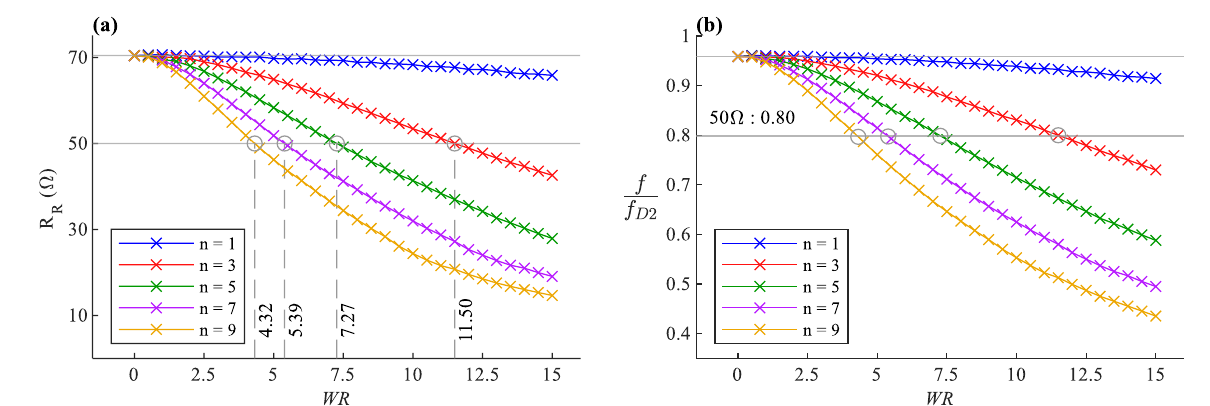
Figure 6. Representation of increasing 𝑊𝑅 of an example antenna with 𝑛 = 3 , while keeping 𝐿 𝐴 as constant and ignoring the fixed wire length 𝐿 𝑊 constraint.